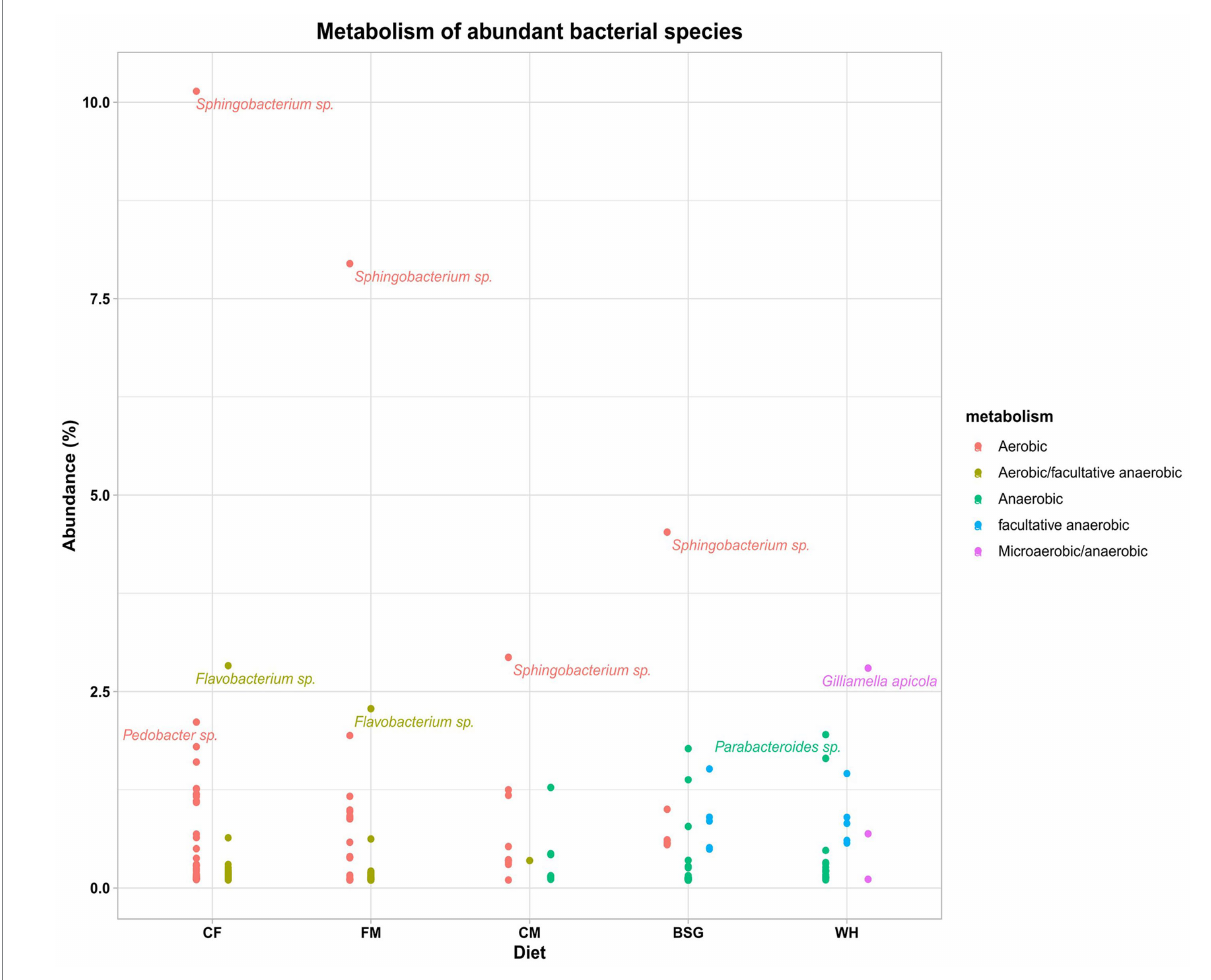
FIGURE 6 The metabolism (aerobic status) of the abundant bacteria in the metatranscriptomes of the BSFL reared on the various diets – chicken feed ( CF ), feed mix (FM), chicken manure (CM), brewer’s spent grain (BSG), and water hyacinth